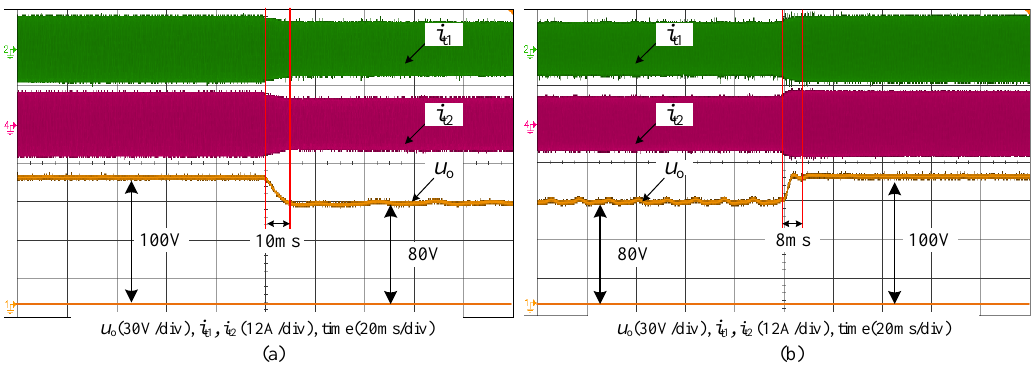
Figure 13. Dynamic tracking performance: ( a ) from 100 V to 80 V; ( b ) from 80 V to 100 V.